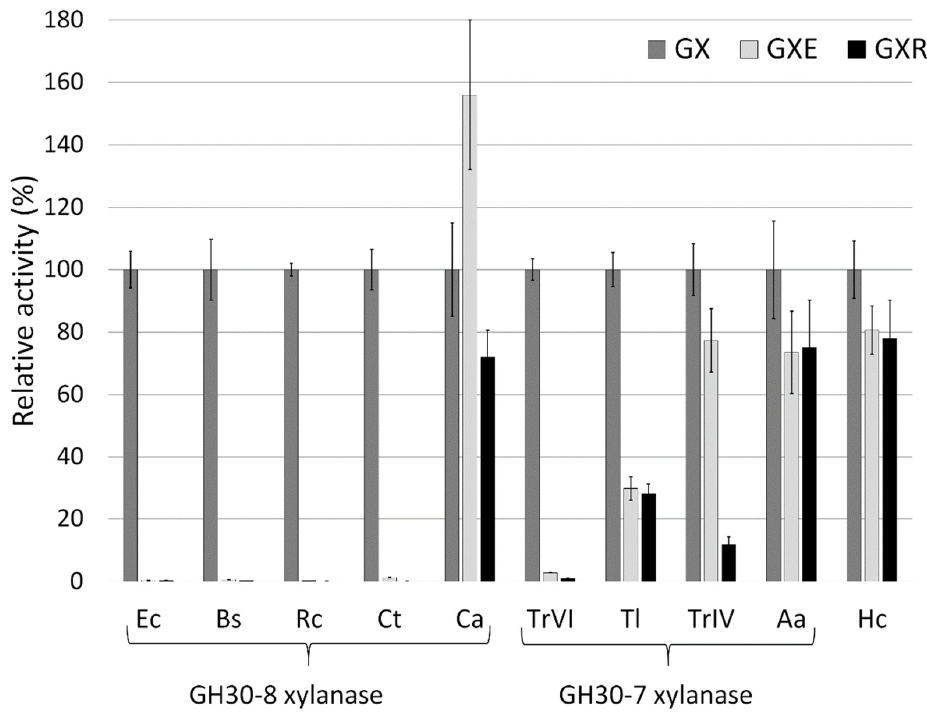
Figure 1. Relative specific activities of GH30-8 and GH30-7 xylanases on GX, GXE and GXR. Hc Xyn30A has not yet been classified to any subfamily.